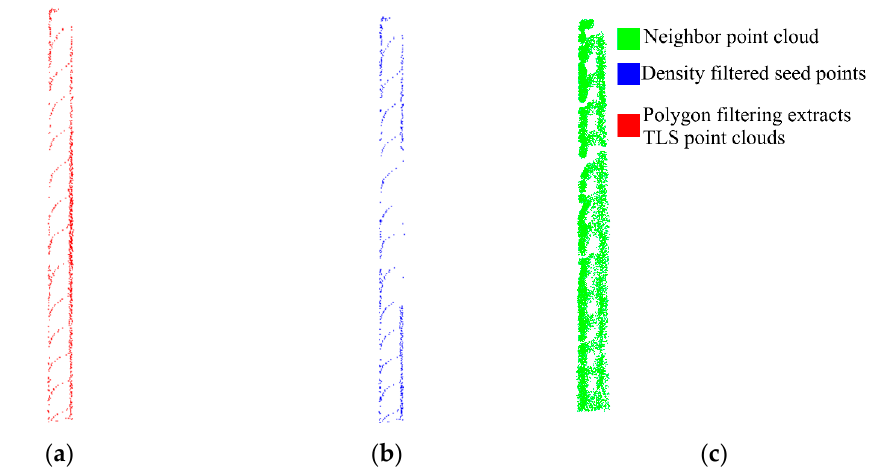
Figure 21. Facade hole data extraction. ( a ) Polygon filtering extracts point clouds. ( b ) Density filtered seed points. ( c ) Neighbor search results.